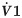
Experimental set up.V˙1
= flow measured with pneumotachograph number 1,
V˙2
= flow measured with pneumotachograph number 2, Paw 1 = pressure measured with pressure transducer number 1, Paw 2 = pressure measured with pressure transducer number 2. Arrows indicate the connection between Paw ports and flow meters to data logger. The location of the clamp into the endotracheal tube is shown. I = inspiration, E = expiration.